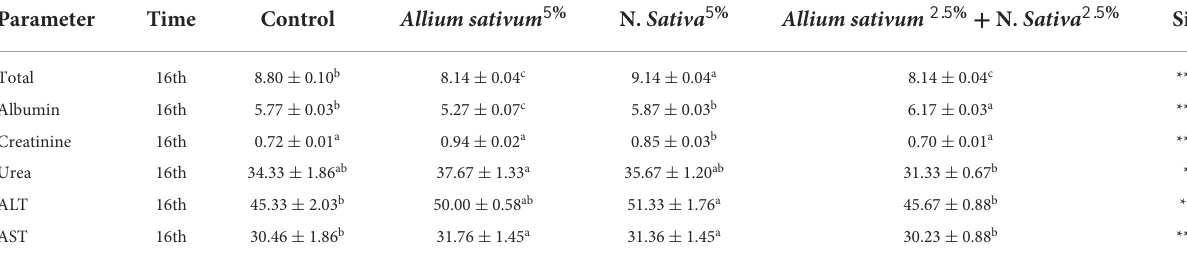
TABLE 2 Serum Biochemical Parameters (mg//dl) in control, aluminum, Allium sativum , and Nigella sativa at 16th week during exposure to aluminum 1,600 ppm toxicity (n = 5/group, mean ± SEM).